Question: What caption would you write for this figure?
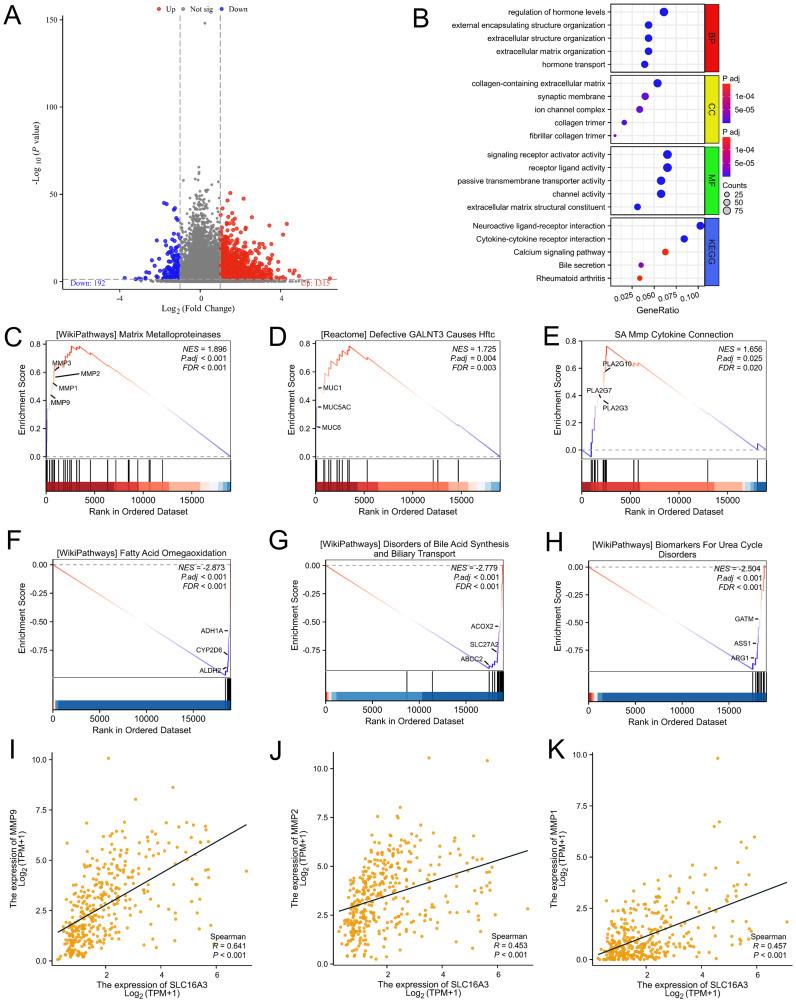
Answer: Functional enrichment analysis of DEGs between SLC16A3 high and low expression groups. (A) The volcano plot of DEGs. Red represents upregulated, blue represents downregulated genes. (B) GO and KEGG pathway enrichment analysis of DEGs. (C–H) GSEA functional enrichment analysis. (I-K) Scatterplots demonstrating the positive correlation of SLC16A3 expression with MMP9, MMP2, and MMP1. For correlation analyses, statistical significance was determined using Spearman’s correlation test. For enrichment analyses, P < 0.05 was considered statistically significant.